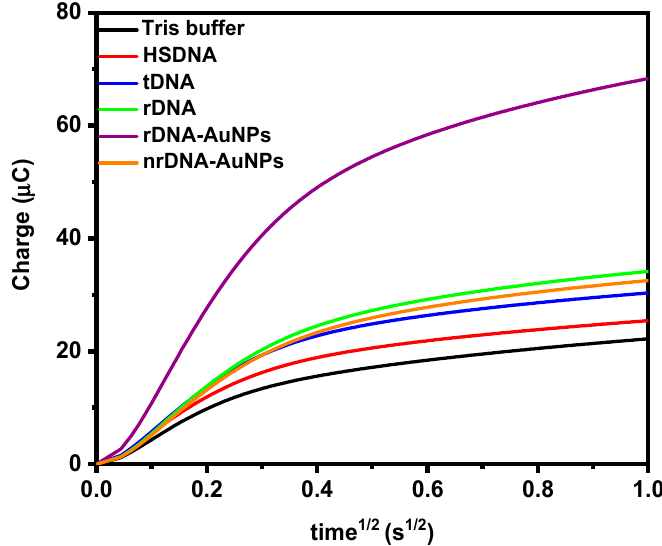
Figure 5. Representative chronocoulometry curves for electrodes unmodified (“Tris buffer”) or modified with HS-DNA (1 µ M) in 10 mM Tris buffer (pH = 7.4) with 50 µ M RuHex before and after hybridization with tDNA (1 µ M), rDNA (1 µ M) and rDNA-AuNPs (0.66 nM) as amplification response. Likewise, the control measurement with nrDNA-AuNPs (0.7 nM).